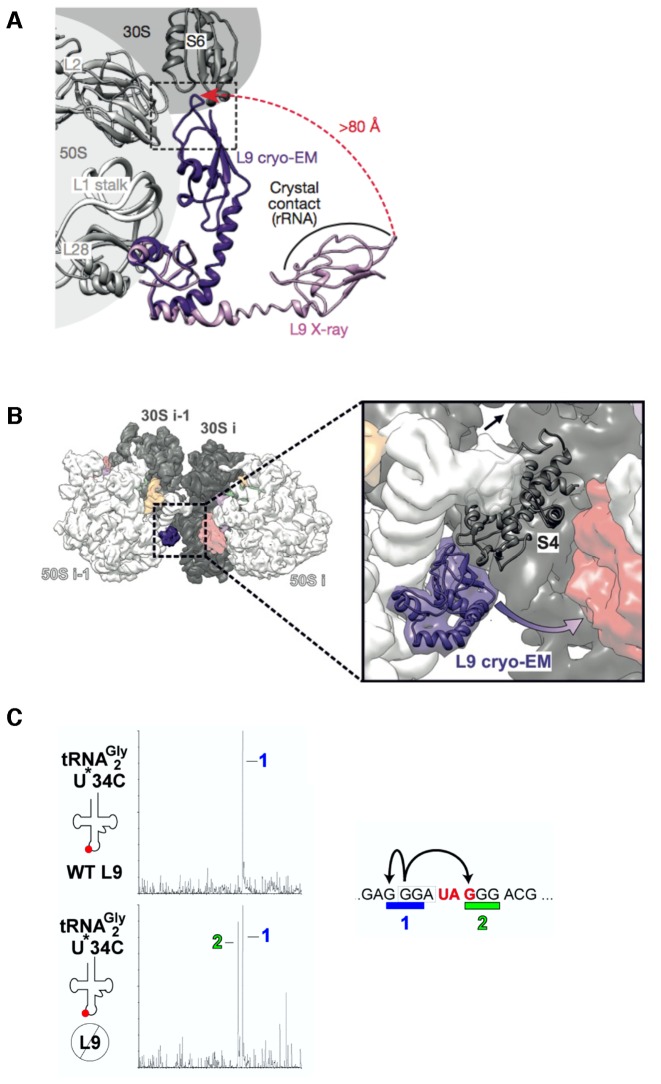
The mobile bacterial ribosome protein L9 that restrains forward mRNA slippage. Its N-terminal domain binds to the large subunit L1 stalk relevant to E-site tRNA egress. (A) Cryo-EM visualization of the L9 carboxy-terminal domain contacting ribosomal proteins (L9 is purple) versus the elongated form of L9 (in pink) detected in crystals. In crystals, instead of the L9 carboxy-terminal domain interacting with the 30S subunit of the same ribosome, it interacts with the 16S rRNA of a neighbouring ribosome. Whether this is a crystal artifact or indicative of a ‘strut’ function in polysomes relevant to frameshifting is unknown. (B) Model of L9 in the context of polysomes. This shows the arrangement of neighboring ribosomes (i-1 and i) in the major t-t form of E. coli polysomes, with the conformation of L9 (blue) revealed by cryo-EM. L9 is located close to protein S4 of the neighboring 30S subunit (30S i) according to the polysome model. The purple arrow indicates the rearrangement of L9 from the cryo-EM conformation to that seen in crystals. The black arrow denotes the location of the mRNA entry channel in the 30S subunit i. Images A and B are from (590). (C) Mass spectral analysis of protein products shows evidence for L9 functioning to restrain forward ribosome slippage on mRNA. Inactivation of L9 (lower panel) shows an additional product (2, in green) due to peptidyl-tRNA anticodon dissociation and re-pairing to mRNA at a 3′ position (indicated on sequence at right). The system used had additional mutants that exaggerate the effect. It involved polysomes, and the effect has not yet been tested with low ribosome loading (484) [Reprinted by permission from Macmillan Publishers Ltd: NATURE (Fischer, N., Neumann, P., Konevega, A.L., Bock, L.V., Ficner, R., Rodnina, M.V. and Stark, H., Structure of the E. coli ribosome-EF-Tu complex at <3 Å resolution by Cs-corrected cryo-EM, Nature, 2015, 520: 567-570), copyright 2015.].